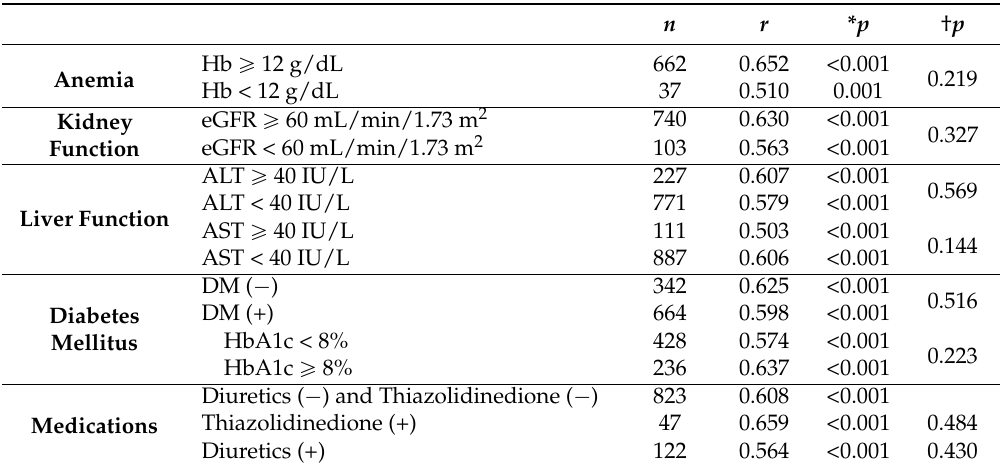
Table 3. Pearson correlation between VFA measured by CT and VFA estimated by BIA in subgroups according to clinical